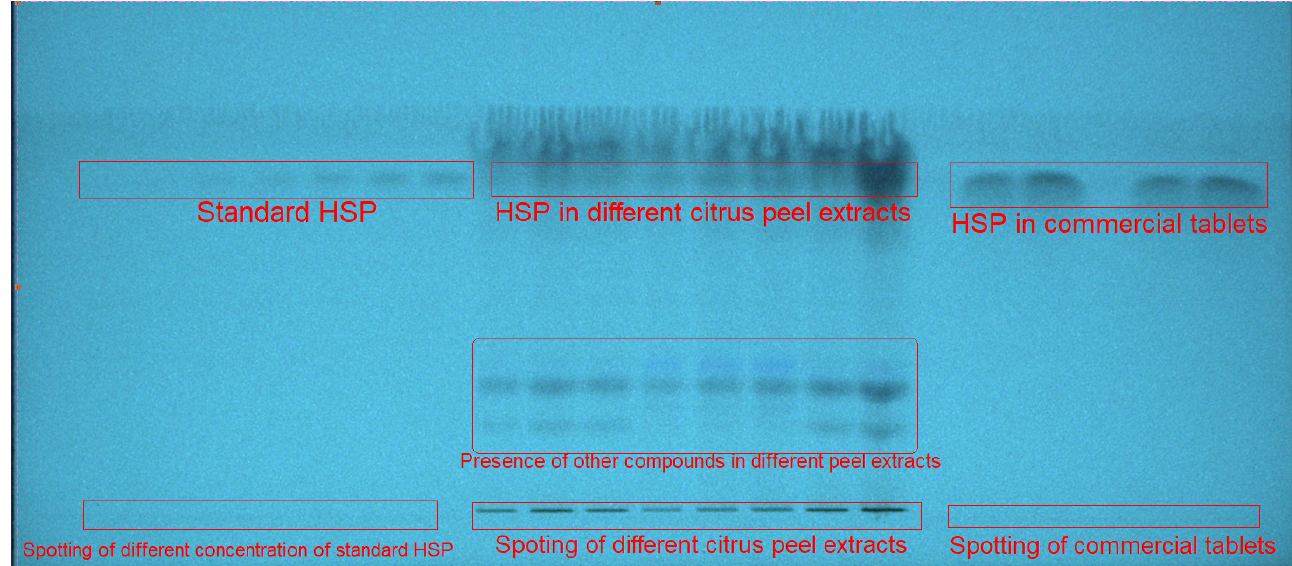
Figure 1. Thin-layer chromatography (TLC)-chromoplate of standard hesperidin (HSP), citrus peel extracts, and commercial tablets developed using EtOH-W (50:50, v v − 1 ) as the mobile phase for a sustainable “reversed-phase high-performance thin-layer chromatography (RP-HPTLC)” assay.